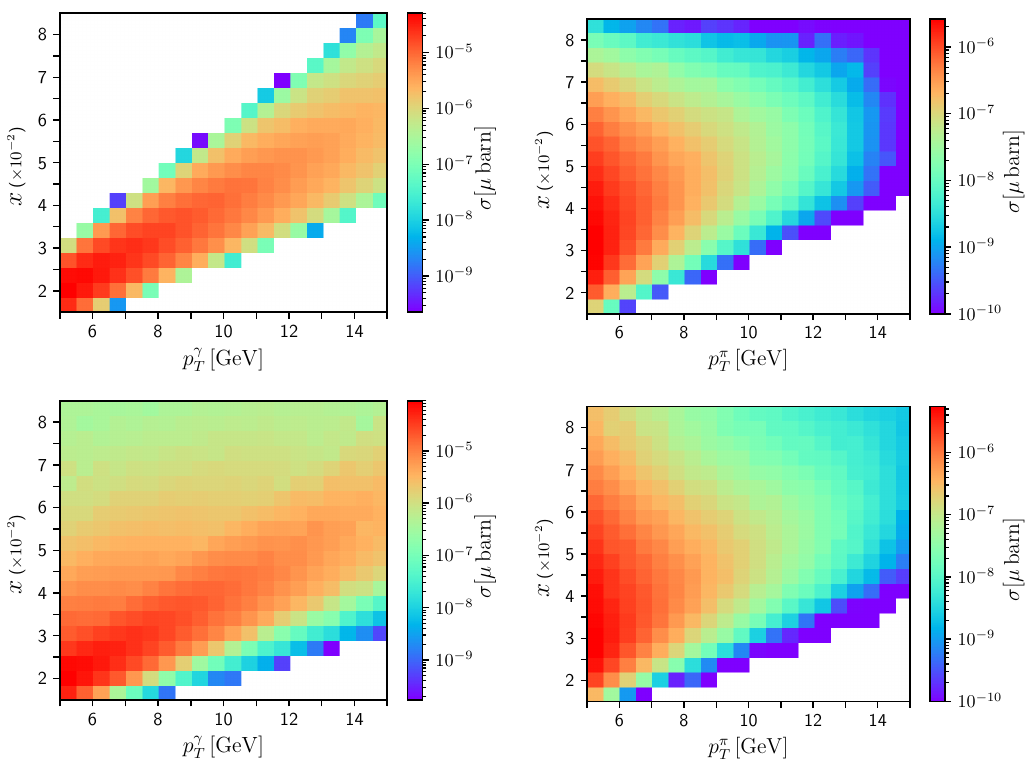
γ (left) and p π as a function of p 1 T T